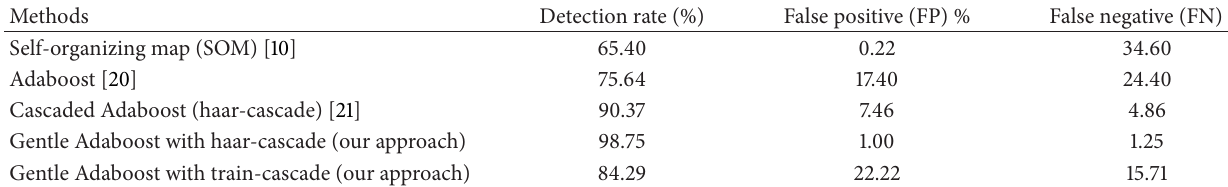
Table 1: Strength and weakness of different nipple detection methods.